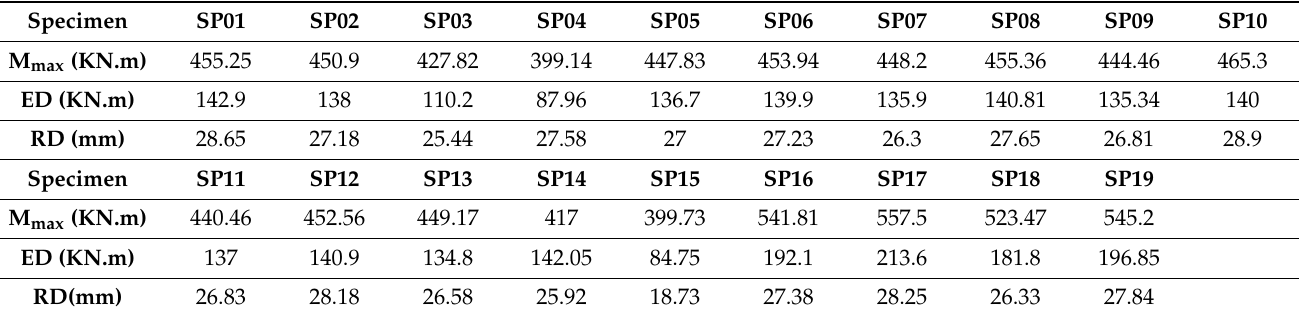
Table 4. Moment capacity, ED capacity, and